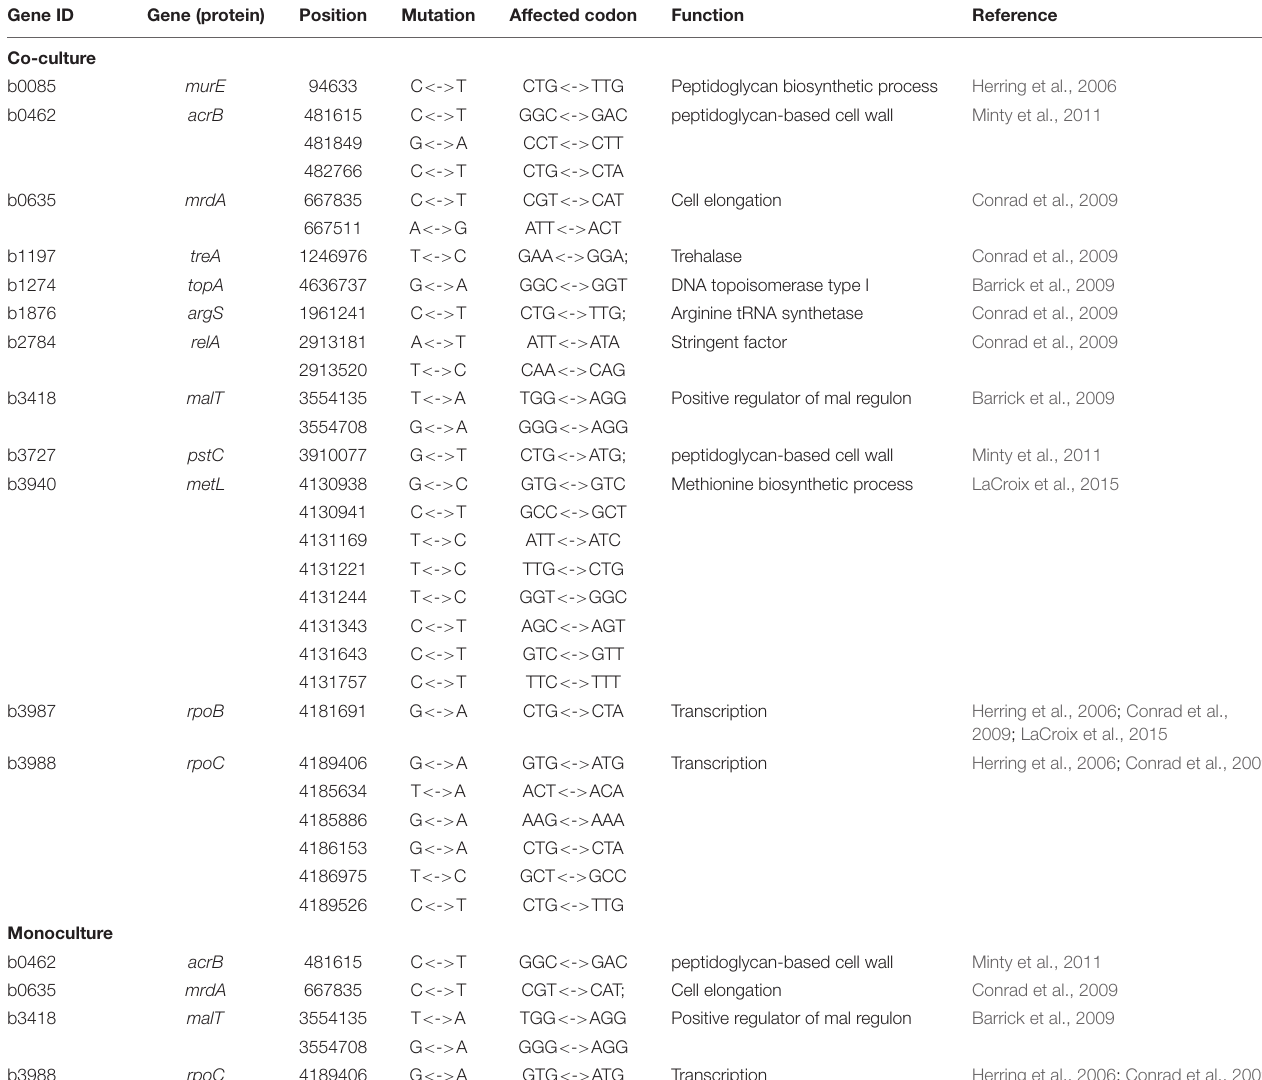
TABLE 1 | Mutations discovered in the sequenced genomes of Escherichia coli strains. Gene ID Gene (protein) Mutation Affected codon